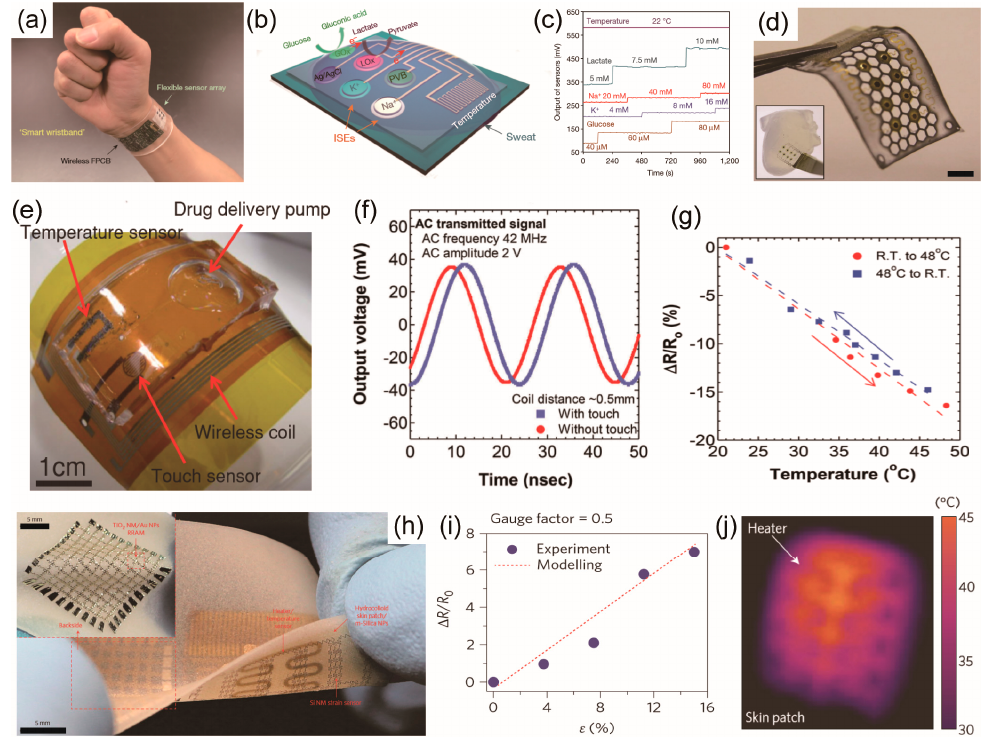
Figure 7. Wearable multiplexed sensors. ( a ) Photograph of a wearable flexible integrated sensing array (FISA) on a subject’s wrist, integrating the multiplexed sweat sensor array and the wireless flexible, printed circuit board (FPCB). ( b ) Schematic of the sensor array (including glucose, lactate, sodium, potassium and temperature sensors) for multiplexed perspiration analysis. GOx and LOx, glucose oxidase and lactate oxidase. ( c ) System-level interference studies of the sensor array. Reprinted with permission from Ref. [38]. Copyright 2014, Nature Publishing Group. ( d ) Optical image of the fabricated ion sensor on a cellular substrate. Ion sensor mounted on a rabbit heart model constructed from agarose gel (inset). (scale bar 2 mm) Reprinted with permission from Ref. [149]. Copyright 2014, John Wiley and Sons. ( e ) Photograph of the fabricated smart band. ( f ) Output AC signal with and without touching. ( g ) Normalized resistance change as a function of temperature. Reprinted with permission from Ref. [62]. Copyright 2014, John Wiley and Sons. ( h ) Photographs of the wearable bio-integrated system. Inset: Wearable 10 × 10 RRAM array on the hydrocolloid side of the patch (scale bars 5 mm). ( i ) Plot of percentage change in resistance versus strain for calculation of the gauge factor ( j ) Temperature distribution measurement of the heater on the skin patch using an infrared camera. Reprinted with permission from Ref. [99]. Copyright 2014, Nature Publishing Group.